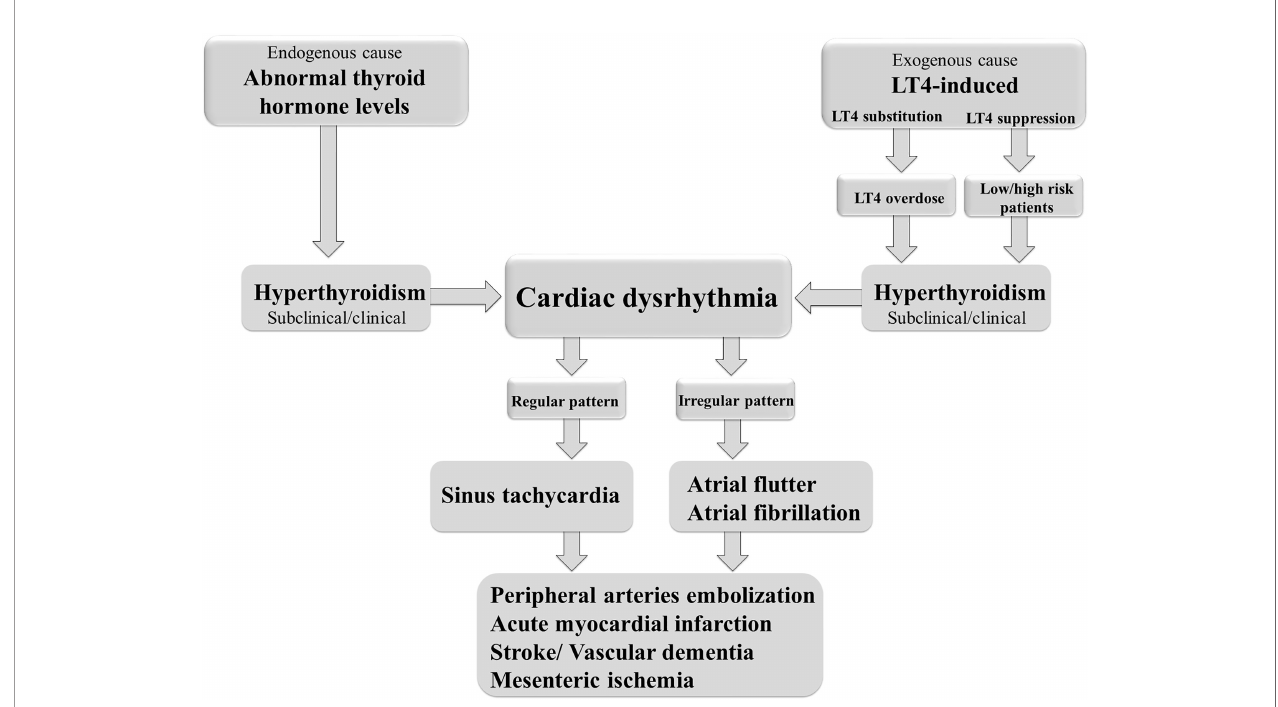
FIGURE 2 | Thyroid dysfunction and the risk of cardiac